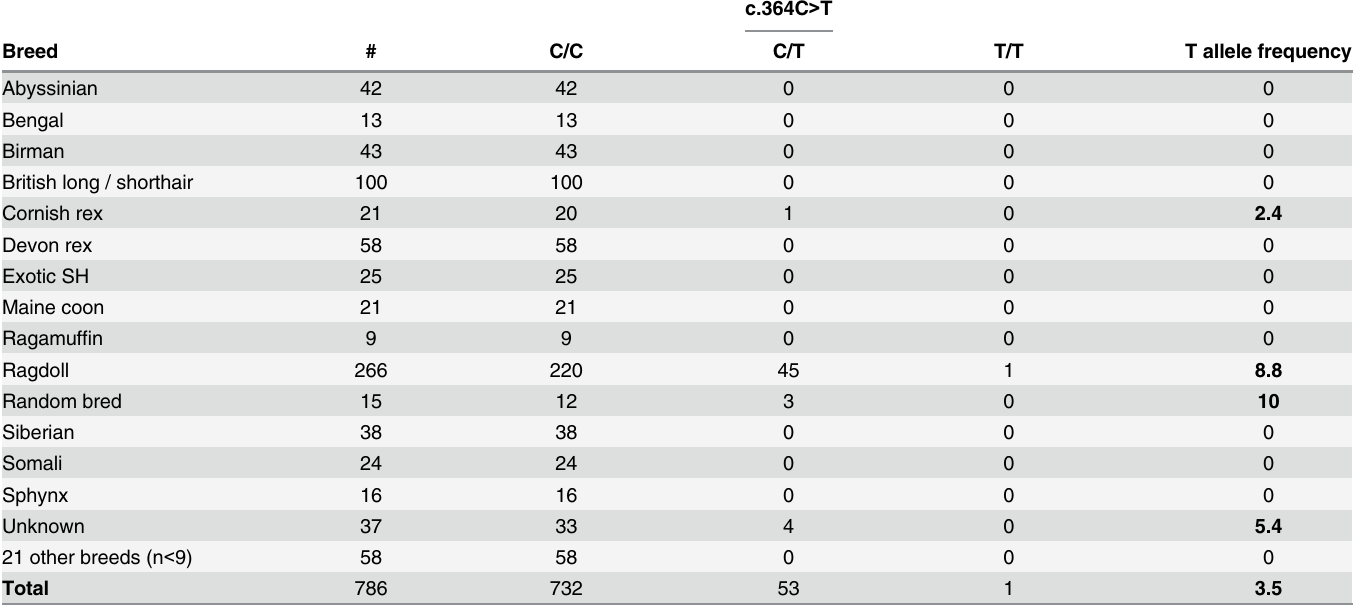
Table 3. Frequency of the CMAH c.364C > T polymorphism in different cat breeds with unknown serology.